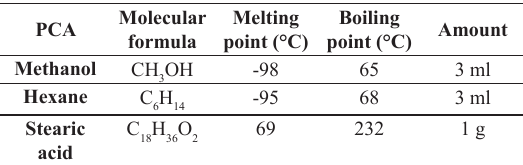
Table 2. Amounts used, corresponding to PCA physical properties [ 30